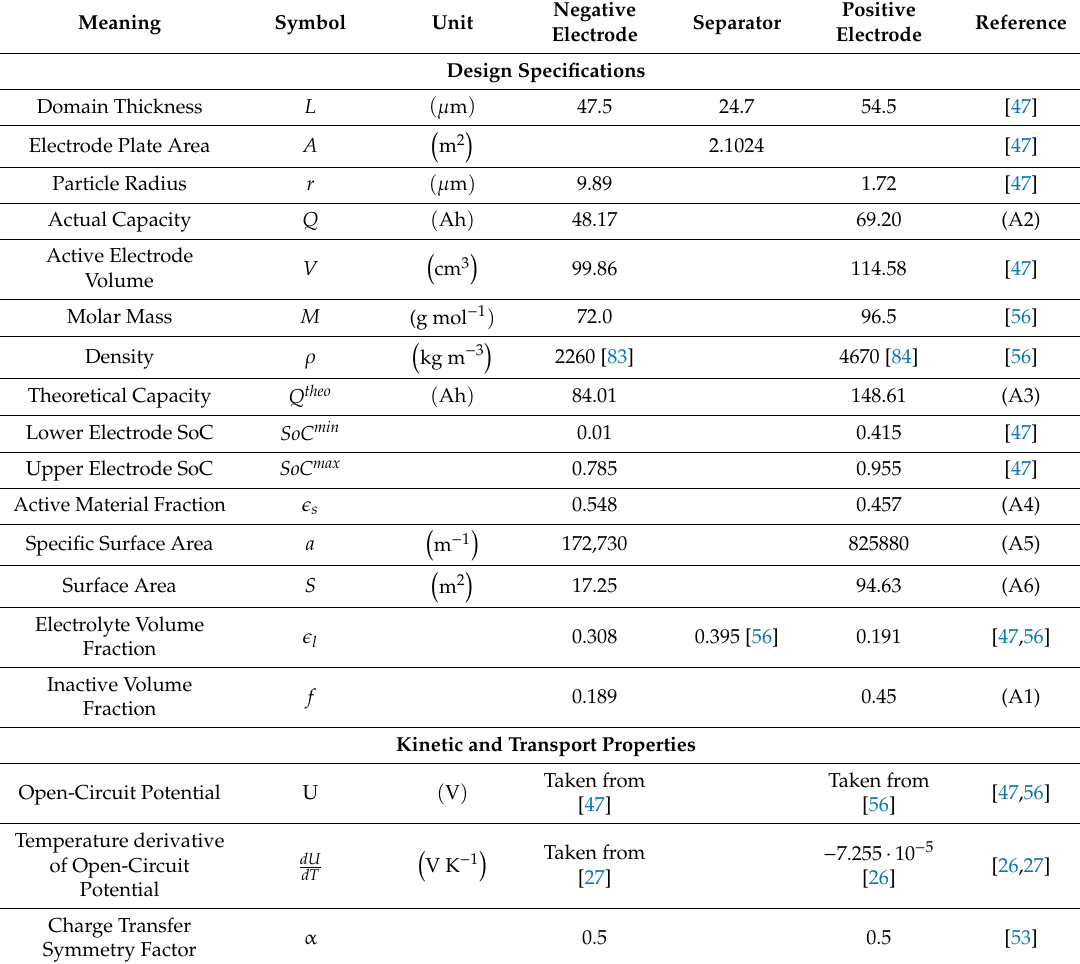
Negative Positive Separator Electrode Electrode